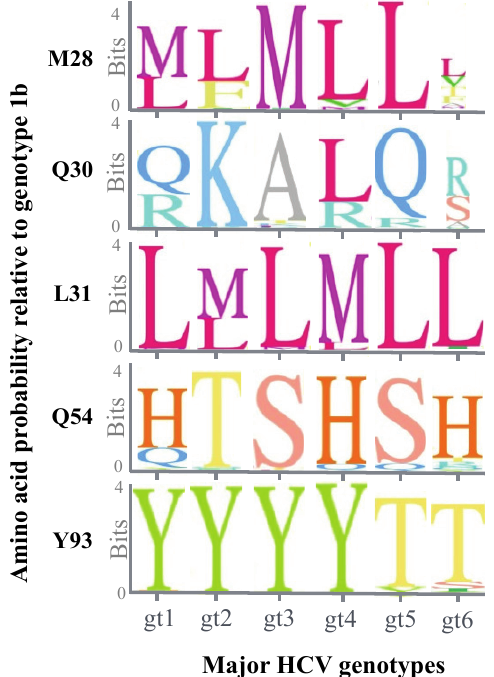
Figure 2. Sequence logo diagram showing sequence heterogeneities at sites associated with DCV resistance. Sequences from each major genotype from the Los Alamos HCV database was aligned using the geneious software [51]. The height of letters representing relevant amino acids indicates their probability at that